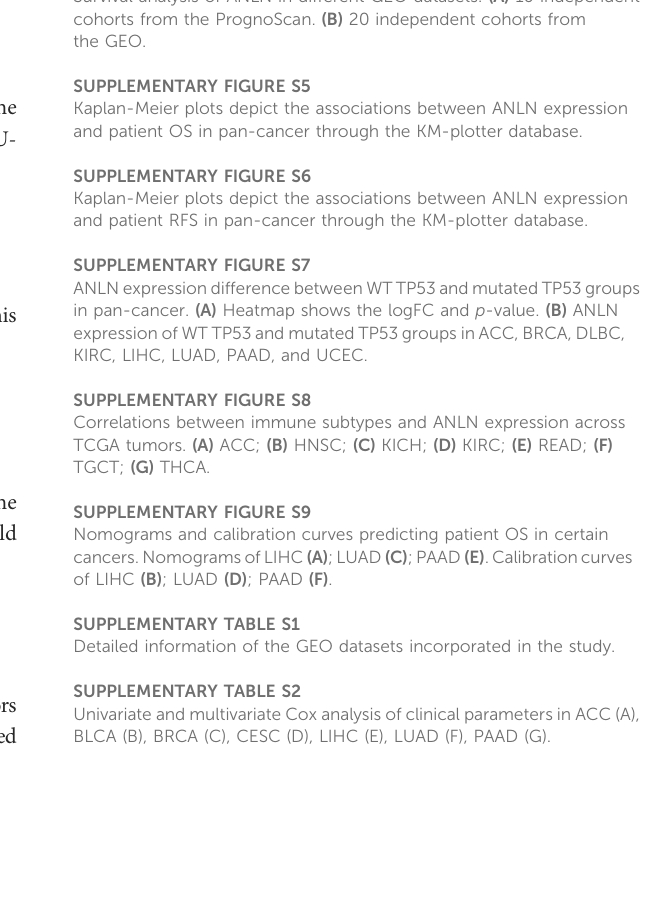
SUPPLEMENTARY FIGURE S3 ANLN protein expression in pan-cancer with signi fi cance, using data